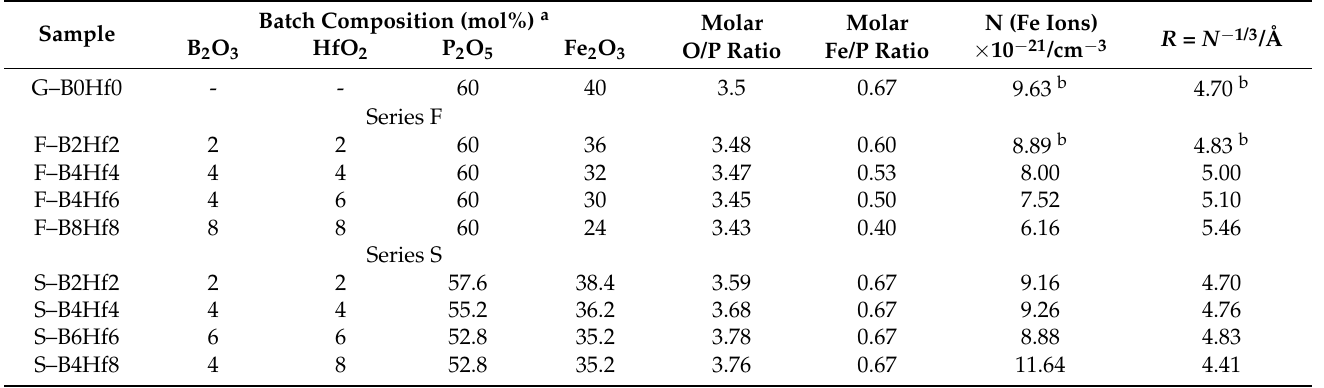
Table 1. Batch compositions and selected properties of studied iron phosphate-based glasses contain- ing B 2 O 3 and HfO 2